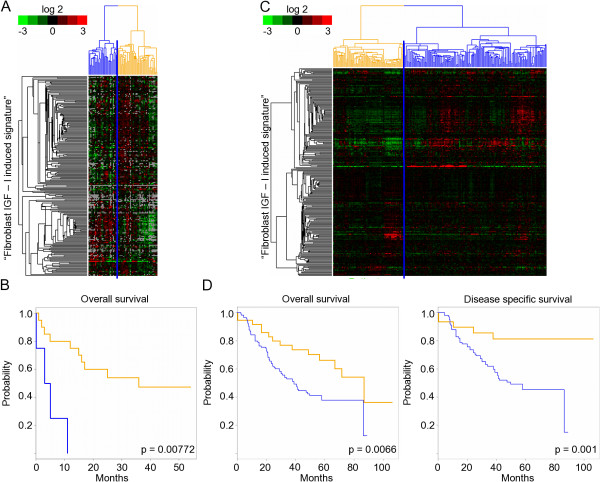
Fibroblast derived insulin-like growth factor-I (IGF-I) signature divides lung cancer patients into two groups with significantly different outcome. (A) Unsupervised hierarchical clustering of fibroblast derived IGF-I signature in Garber lung cancer dataset. The expression values of genes in the fibroblast derived IGF-I signature were extracted from a published expression study by Garber [50]. Genes are presented as rows and the experiments are presented as columns. Although some gene expression data are missing, the fibroblast derived IGF-I signature stratifies lung cancer patients into two groups with high (blue) or low (yellow) expression levels of genes representing the signature. (B) Relationship of expression level of genes building fibroblast derived IGF-I signature with overall survival in Garber data. Kaplan-Meier curves denoting the clinical outcomes of the indicated tumours exhibiting high (blue curve) and low (yellow curve) expression levels of the signature. (C) Unsupervised hierarchical clustering of fibroblast derived IGF-I signature in Bhattacharjee lung cancer dataset. The expression values of genes in the fibroblast derived IGF-I signature were extracted from a published expression study by Bhattacharjee [51]. Genes are presented as rows and the experiments are presented as columns. Fibroblast derived IGF-I signature stratifies adenocarcinoma patients into two groups with high (blue) or low (yellow) expression levels of genes representing the signature. (D) Relationship of expression level of genes building fibroblast derived IGF-I signature with overall survival and disease specific survival in Bhattacharjee dataset. Kaplan-Meier curves illustrating the clinical outcomes of the indicated tumours exhibiting high (blue curve) and low (yellow curve) expression levels of the signature.